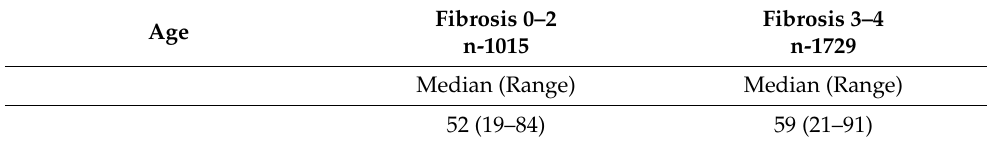
Table 2. Age distribution depending on HCV